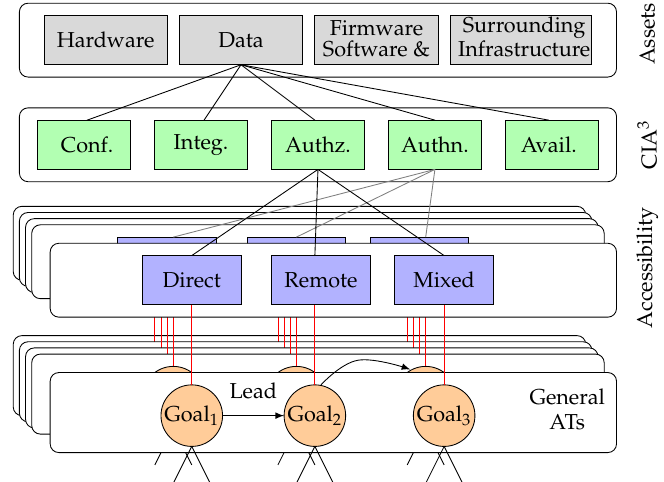
Figure 4. SAVTA method procedure to identify threats and link them to general attack trees.